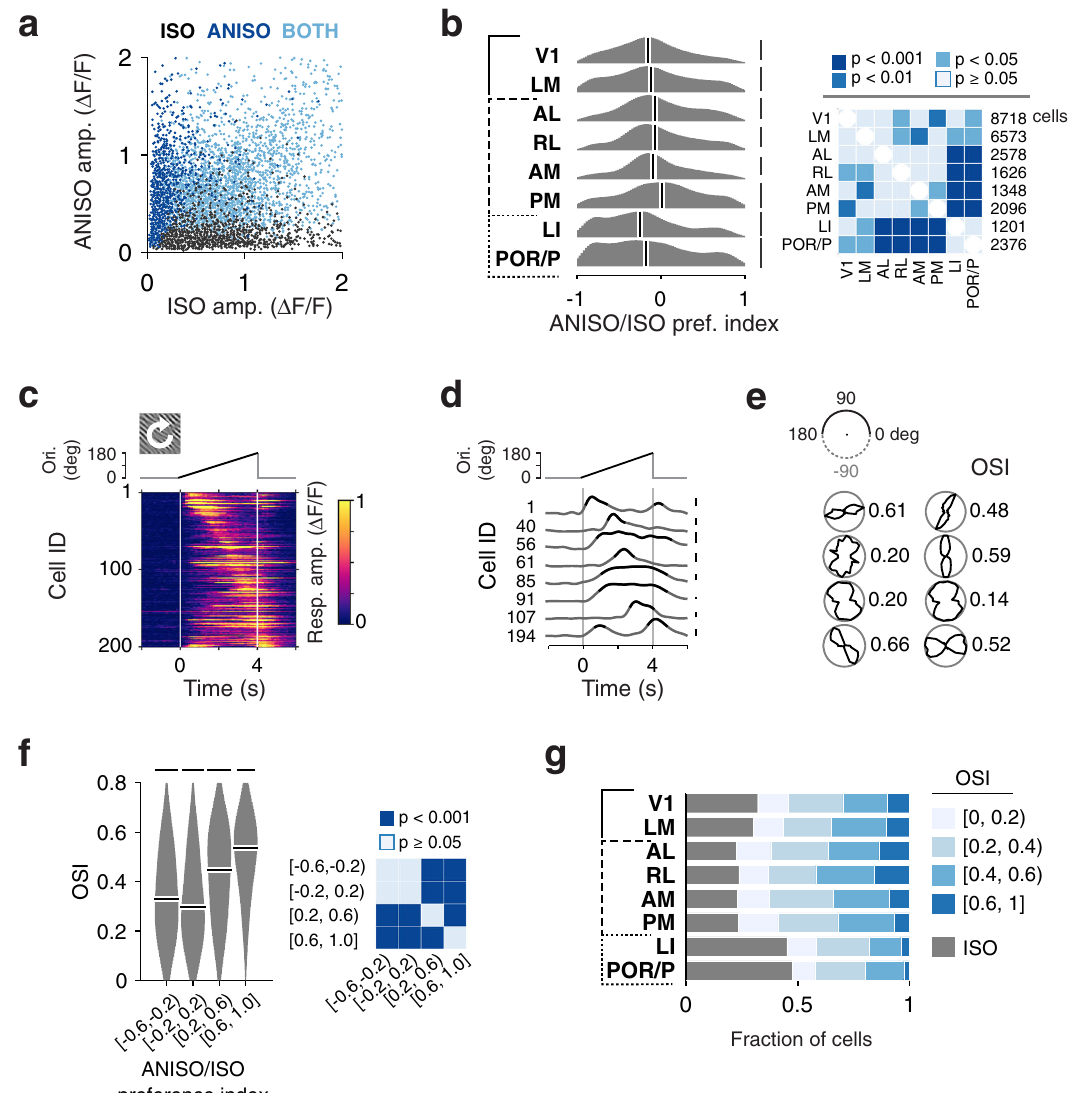
Fig. 5 Diverse responses to oriented and non-oriented stimuli in ventral and dorsal visual areas. a Scatter plot showing diverse amplitudes of visual cortical neurons ’ responses to isotropic (ISO) and anisotropic (ANISO) stimuli (datasets 1 – 2). Dark blue, gray, and light blue dots represent cells showing reliable responses to ANISO stimuli only, ISO stimuli only, and to both types of stimuli, respectively. b Quanti fi cation of neurons ’ ANISO/ISO preference for populations in each area. The ANISO/ISO preference index (API) is de fi ned as the ratio of the difference in peak responses to the stimuli over their sum. For each distribution: Kernel density estimator bandwidth 0.1; scale bar: 2% cells; white bars: median value. Right panel: two-sided hierarchical bootstrap KS tests for pairwise comparison. c Calcium traces of 200 randomly-selected V1 neurons in response to ANISO stimuli of time-varying orientation (icon, top inset). In these recordings, time to response peak and response dynamics can be used to estimate orientation preference and selectivity, respectively. Vertical lines at 0 and 4 s indicate onset and offset of visual stimulus. The top inset indicates the time-varying orientation of the visual stimulus. d Subset of the data shown in c plotted as traces. The part over 50% peak amplitudes in each trace is shown in black. Scale bar: 0.3 Δ F/F. e Approximate orientation tuning curves estimated from the response time courses shown as polar plots, for example neurons in d (left to right, top to bottom). Black curves show peak-normalized calcium response amplitudes to different orientations. The upper half of the polar plot is duplicated, rotated, and shown in the lower half, presented together to add visual ease. Estimated orientation selectivity index (OSI), quanti fi ed as (1 – circular variance), is indicated for each neuron (details in Methods, Supplementary Fig. 11). f Distributions of OSI values for cells with distinct ranges of ANISO preference index. Neurons with high API values show high OSI values indicative of sharp orientation tuning, whereas neurons with low API values show lower OSI values indicative of weaker orientation selectivity. Scale bars: 2.5% cells. Two-sided hierarchical bootstrap KS tests (right panel). g Fraction of neurons showing different orientation selectivity in different